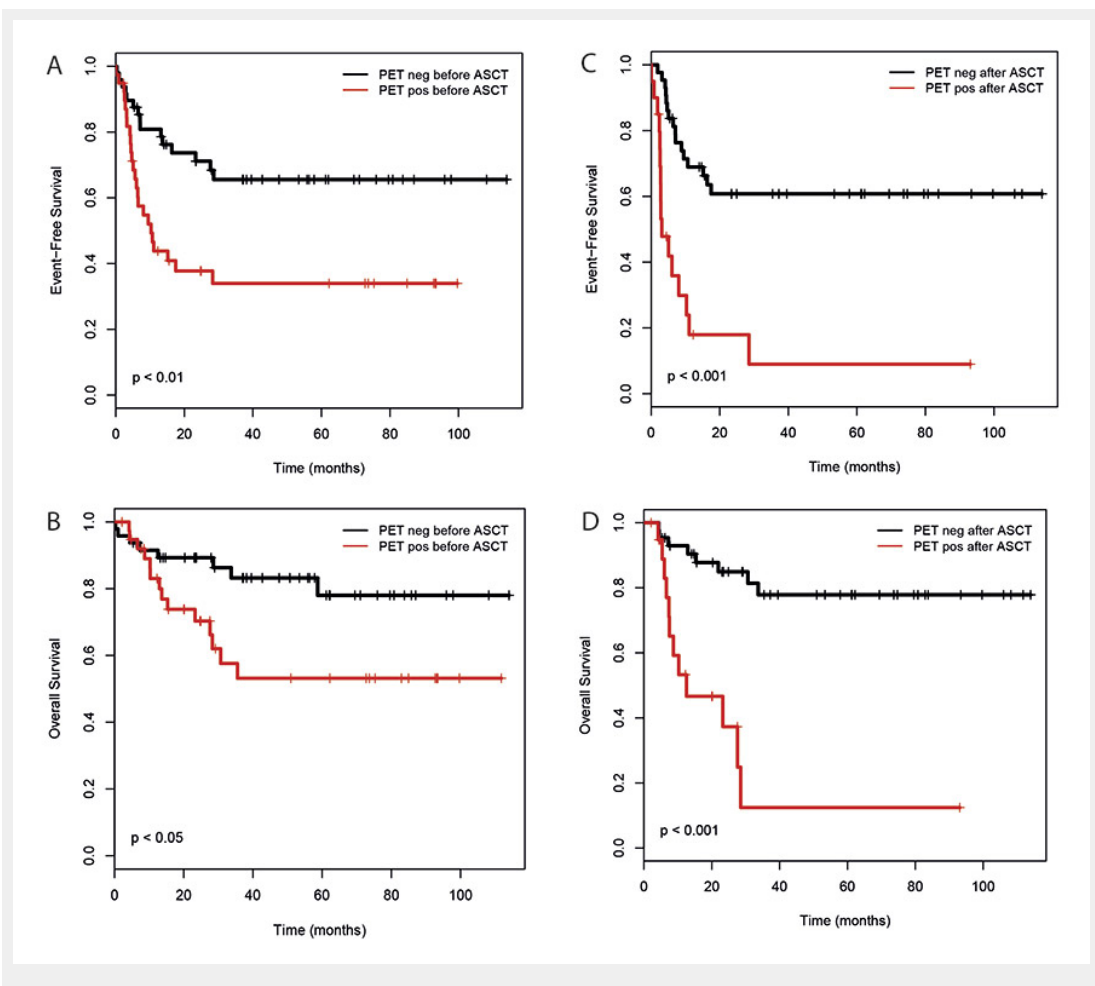
Figure 4 Impact of pre- and post-transplantation PET/CT on event free survival (A, C) and overall survival (B, D) in all patients. Pre-transplantation PET/ CT was done during or after induction chemotherapy, post-transplantation PET/CT was done within 3 months after